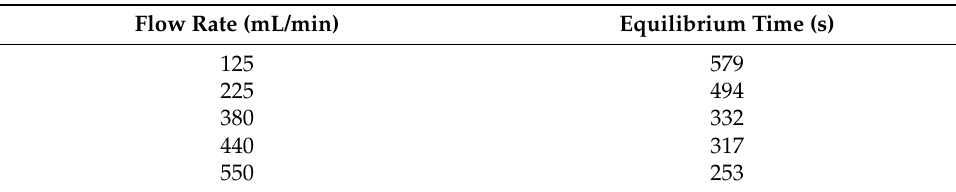
response time variation with the flow rate ( b ). Table 3. The equilibrium times at different flow